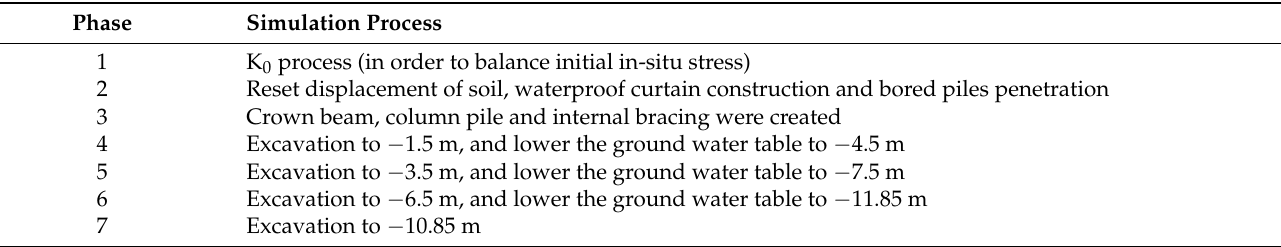
Table 3. Stages of realization of the excavation.